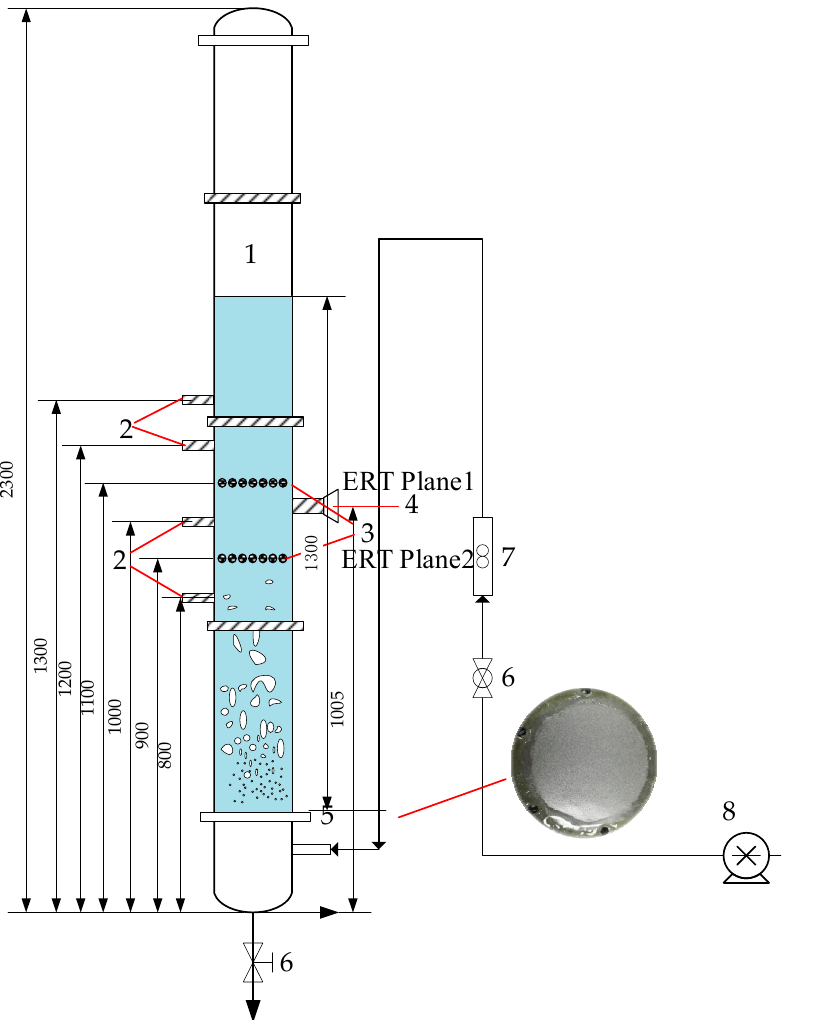
Table 1. Physical properties of gas–liquid phase.